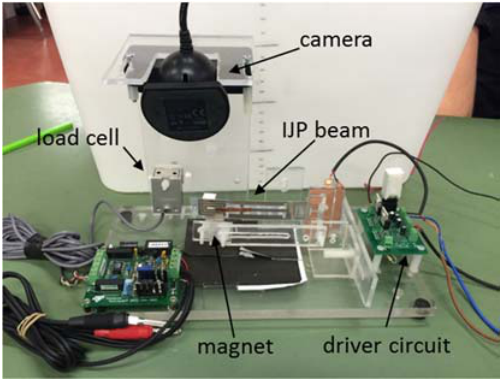
Figure 4. The experimental setup. Table 4. The magnetic field B DC as a function of the permanent magnet position.